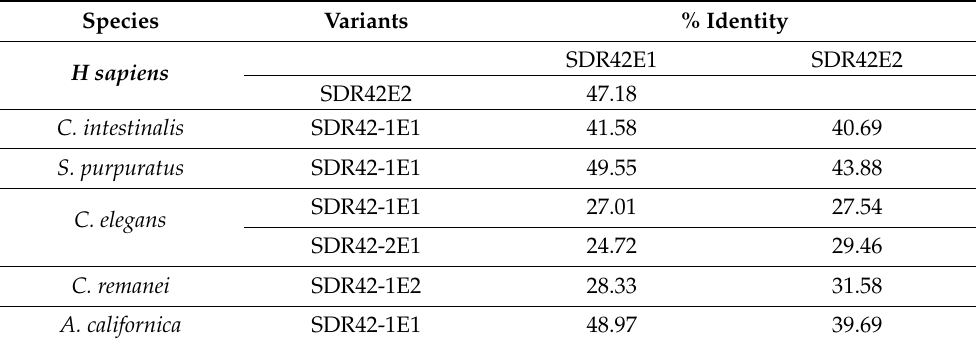
Figure 2. Alignment of the human SDR42E protein variants. × and + symbols mark the structure consensus and the catalysis consensus respectively. For further details, see Figure 1. Table 7. Percent identity values of the human SDR42E family variants and of their invertebrate Table 5. Genetic and molecular data of the human SDR42E family variants . For further details, see Table 1.